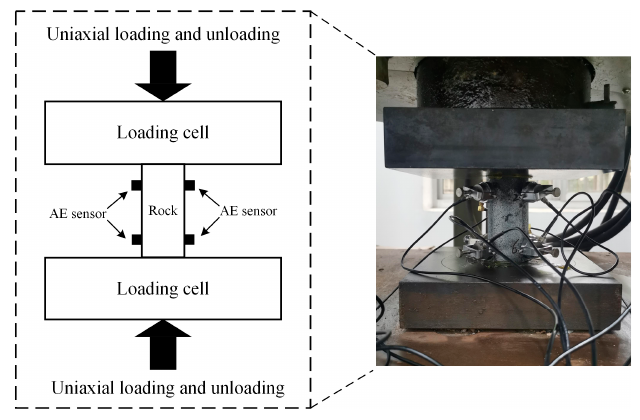
Figure 2. Schematic diagram of